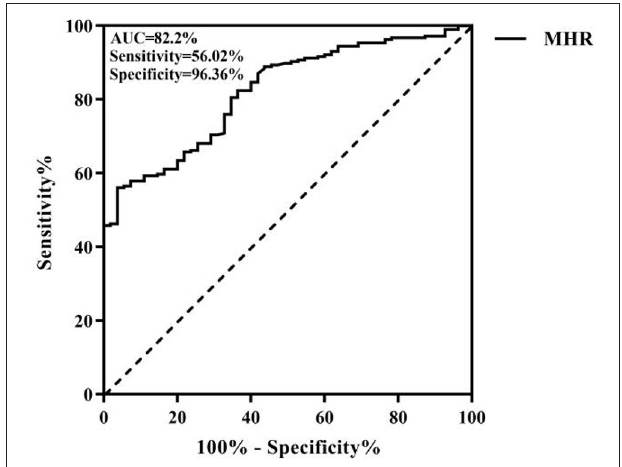
FIGURE 1 | Receiver operating characteristic (ROC) curve of the monocyte/high-density lipoprotein ratio (MHR) for intracranial and extracranial atherosclerotic